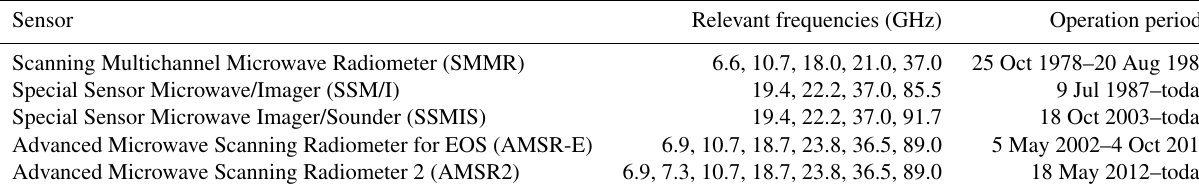
Table 1. Overview of relevant multichannel satellite microwave sensors.